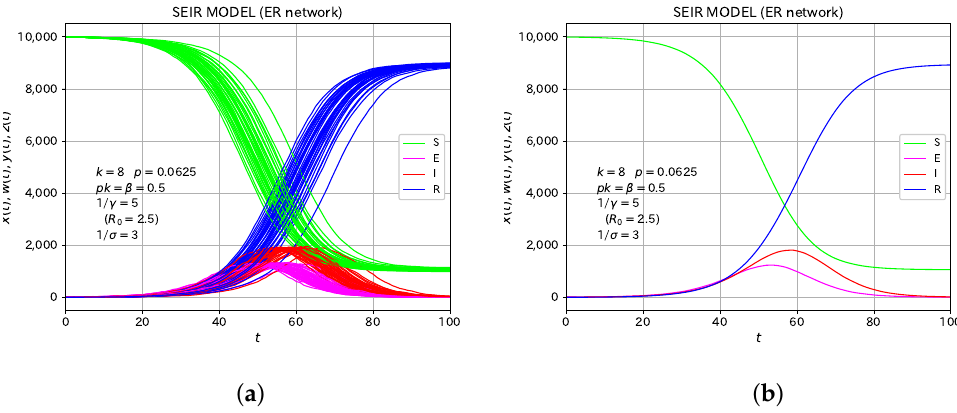
Figure 15. The simulational results of the microscopic SEIR model on the ER network. ( a ) All the results of 40 samples are plotted; ( b ) the average over 40